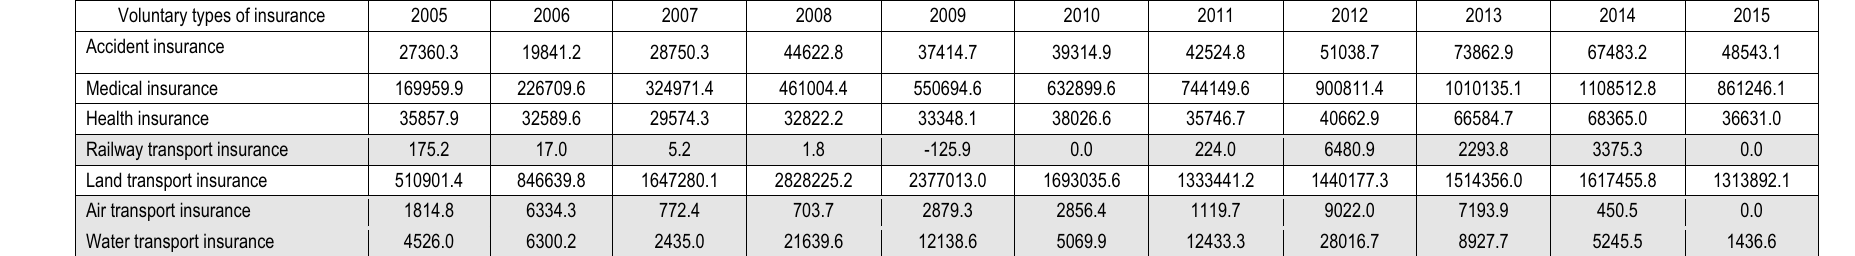
Table 2. Net insurance payments for certain types of insurance in 2005-2015, thousand